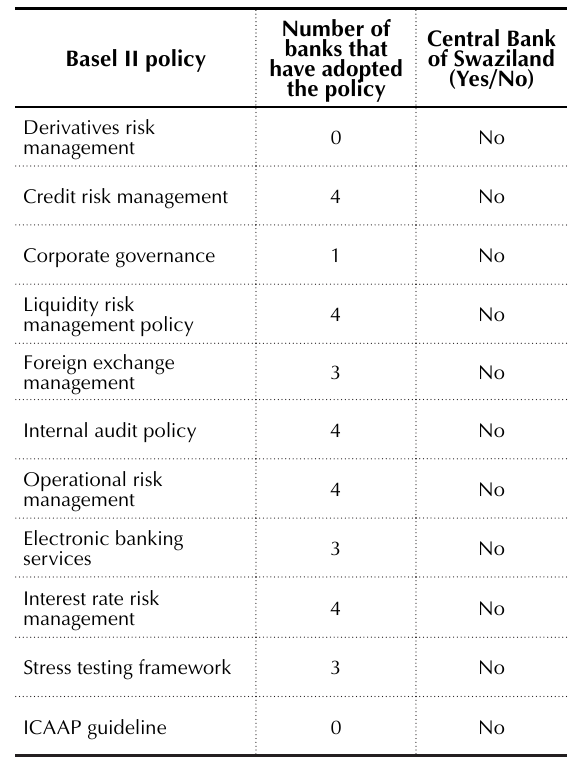
Table 4. Basel II compliant